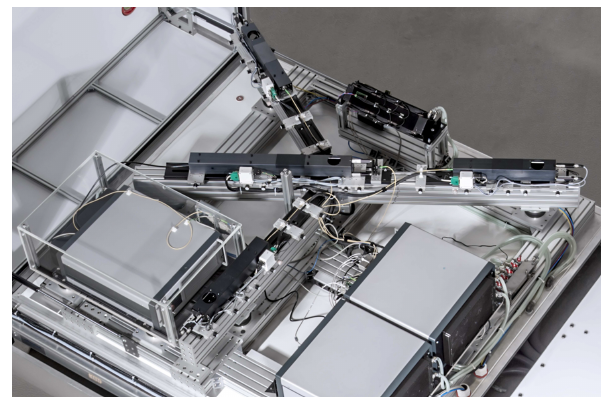
Figure 4. Optical installation inside the PTB lidar trailer (opened trailer